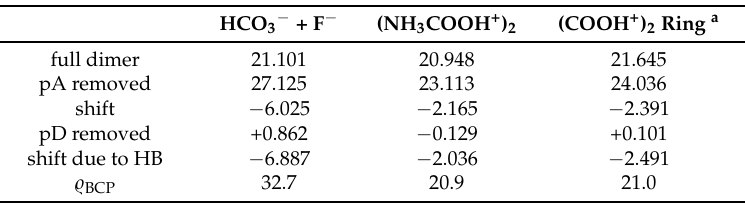
Table 5. NMR isotropic shielding (ppm) of ion-ion structures shown in Figure 6, along with density at bond critical points ( (cid:36) BCP ) in 10 − 3